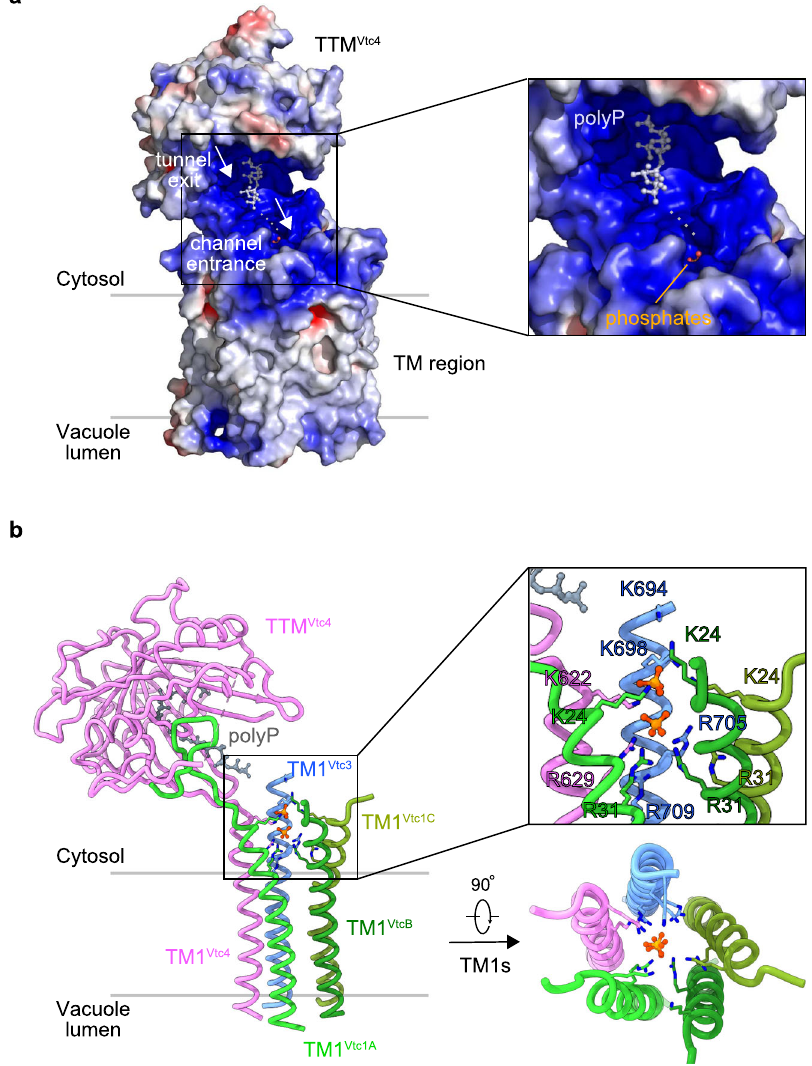
Fig. 4 | A continuous and positively charged belt on the path from the tunnel exit of catalytic TTM Vtc4 to the entrance of trans-membrane channel. a Electrostatic surface of TTM Vtc4 and TM region in InsP 6 -activated Vtc1/Vtc3/ Vtc4 R264A/R266A/E426N complex. It is calculated with the APBS plugin in PyMOL, coloredintermsofelectrostaticpotential,anddisplayedinascalefromred( − 5kT/ e) to blue (+5 kT/e). The previously reported structure of isolated TTM Vtc4 domain bound to polyP (3G3Q.PDB 12 ) is superimposed to TTM Vtc4 in the entire VTC com- plex, with an RMSD of 0.62Å. PolyP in the previously reported structure and